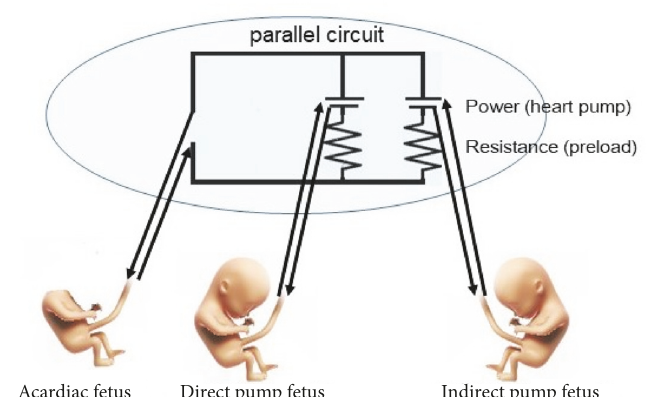
Figure 3: Schematic representation of the anastomosed blood vessels between triplets B and C. The anastomosed blood vessels comprised a parallel circuit, which provided blood flow to triplet